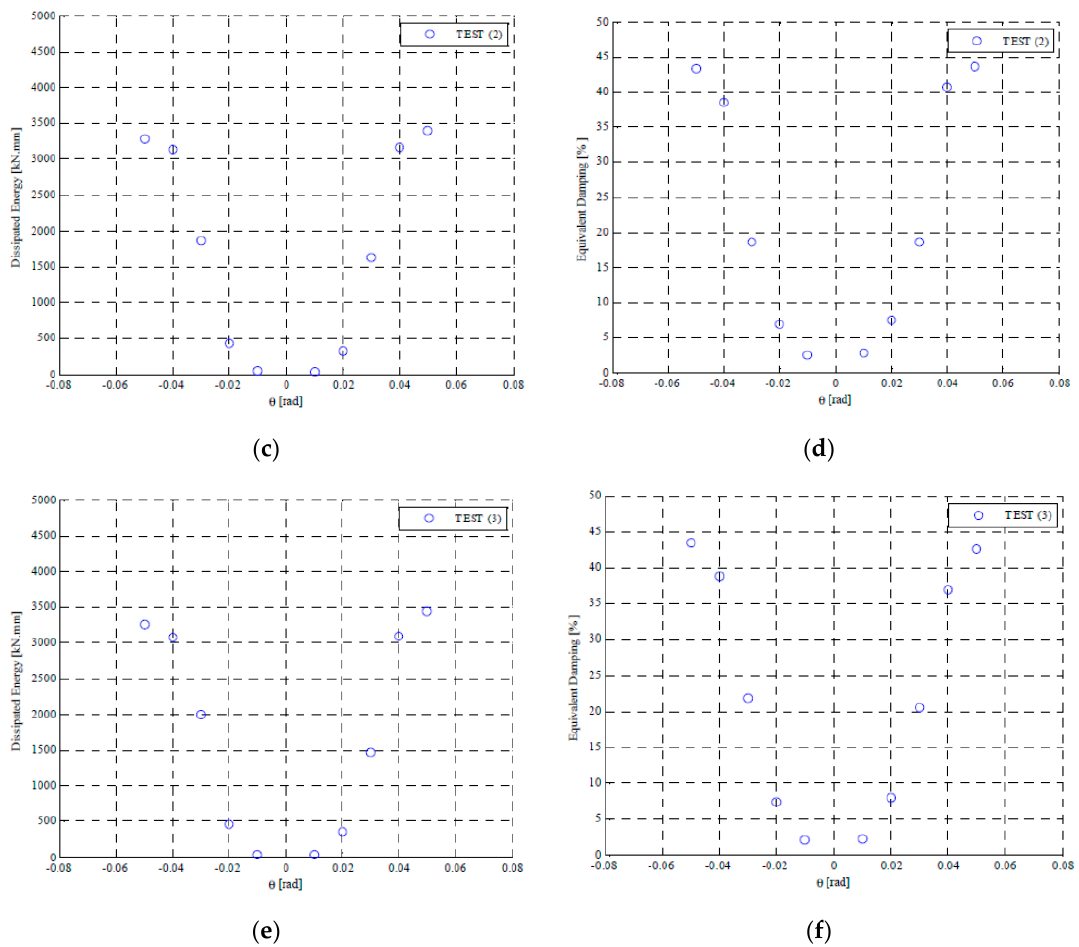
Figure 9. ( a ) Dissipated energy vs. rotation curve of test 1, ( b ) equivalent damping vs. rotation curve of test 1, ( c ) dissipated energy vs. rotation curve of test 2, ( d ) equivalent damping vs. rotation curve of test 2, ( e ) dissipated energy vs. rotation curve of test 3, ( f ) equivalent damping vs. rotation curve of test 3.